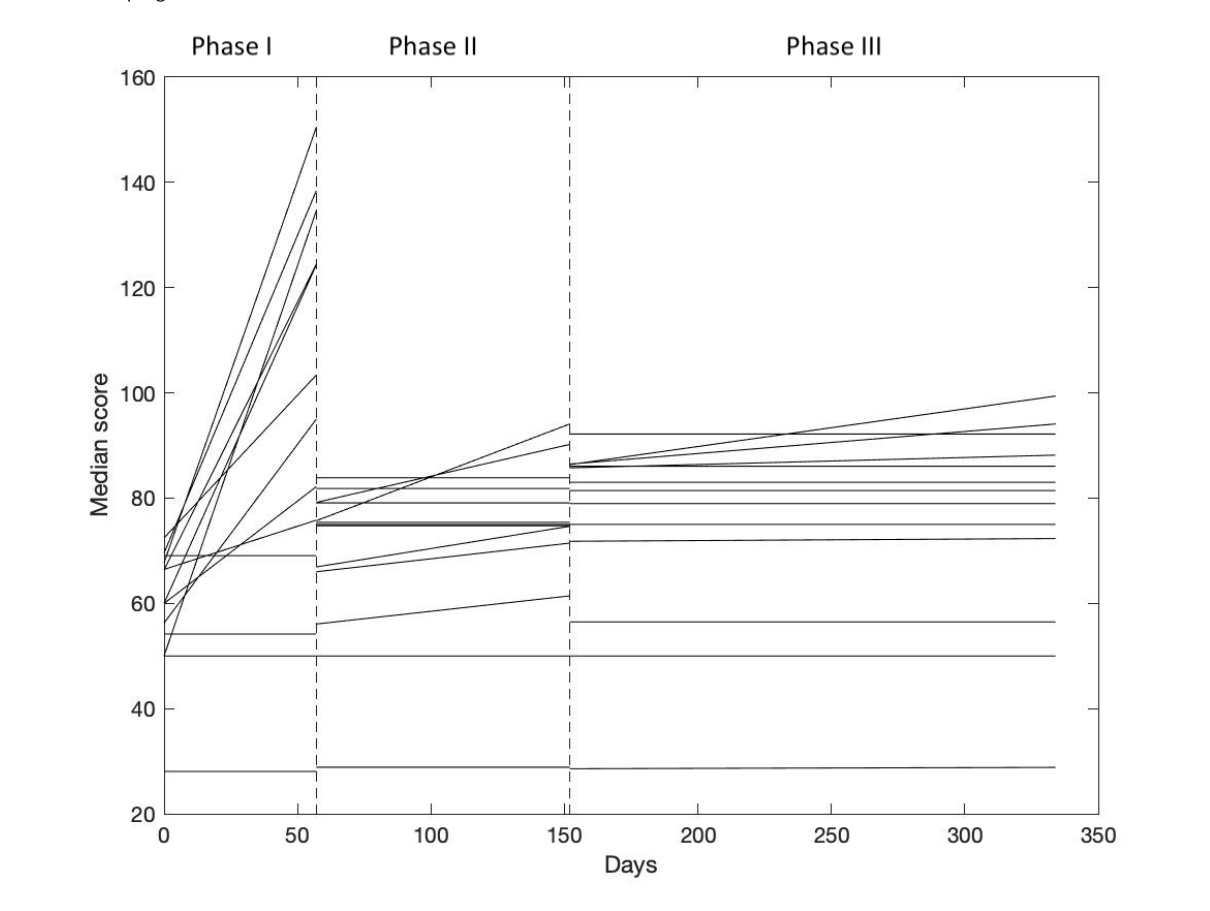
Figure 4. Changes in median scores from the 13 dimensions of the questionnaires. Dotted lines indicate a change in phase in the Future Patient Telerehabilitation program.